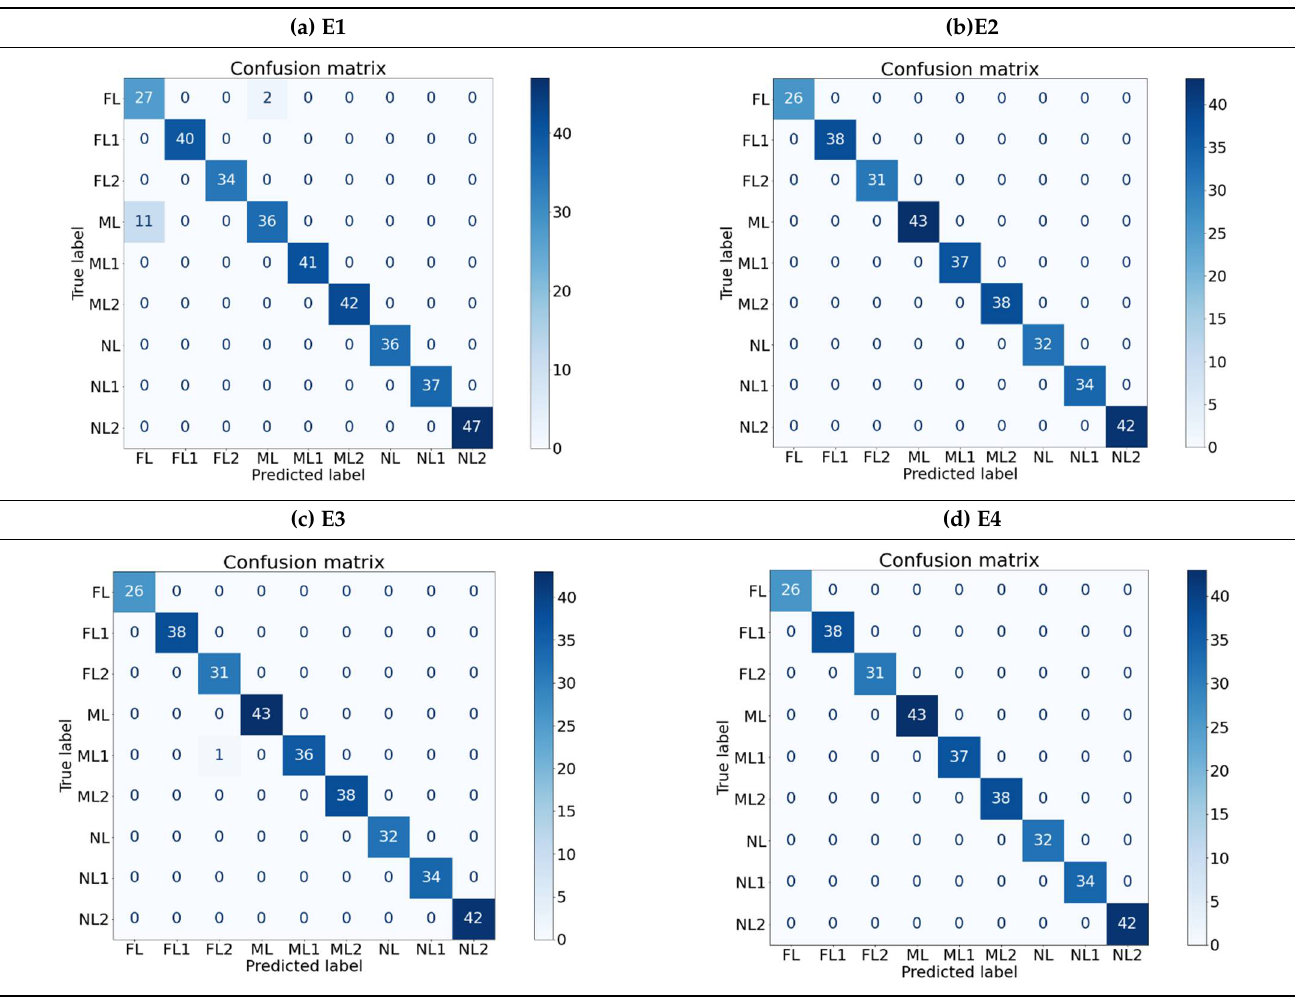
Table 5. Confusion matrices of selected experiments.